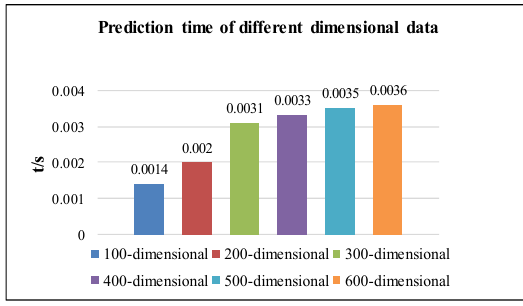
Figure 7. Prediction time of different dimensional data.